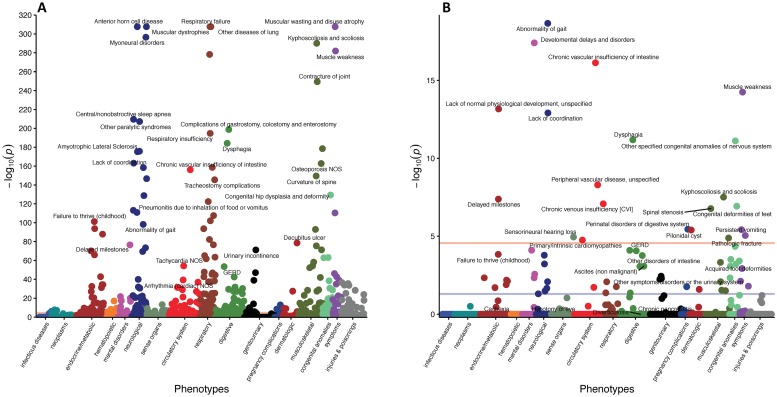
Manhattan plots of phenotypes with increased prevalence in SMA for Group B.(A) shows phenotypes with increased prevalence in SMA patients compared to controls throughout their entire coverage window. Only selected phenotypes with p-value<1e-50 are displayed. (B) Phenotypes with increased prevalence in SMA patients compared to controls from only data prior to their first sign of neuromuscular degeneration. Only phenotypes with p-value<0.005 are displayed. For both plots, the purple line represents an adjusted p-value of 5x10(-2) and the peach line represents an adjusted p-value of 5x10(-4). Completes lists of phenotypes are presented in the supplemental tables.